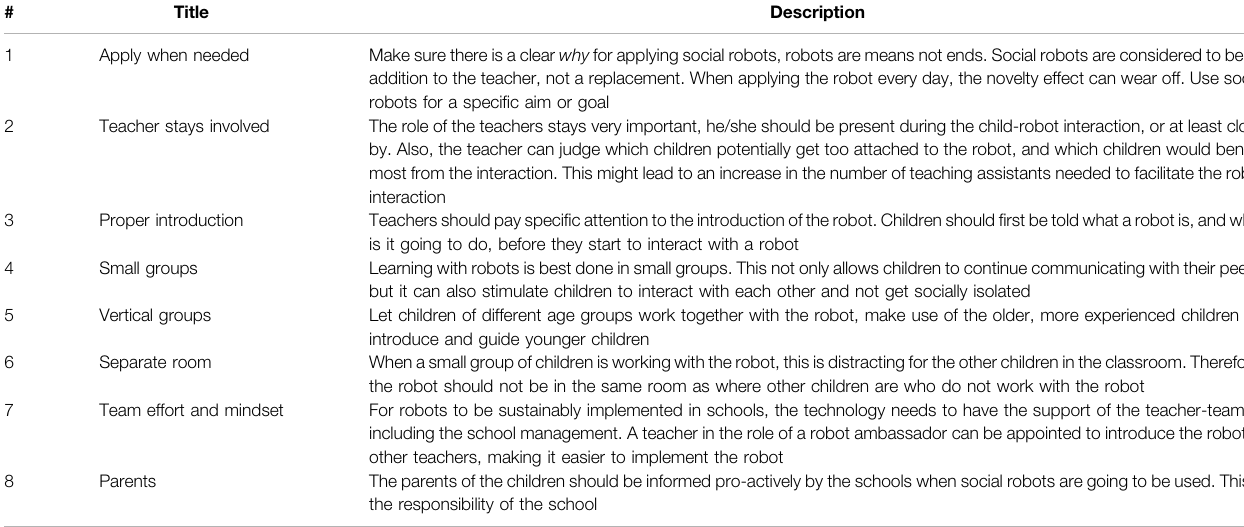
TABLE 2 | Best practices and success factors for applying social robots in primary